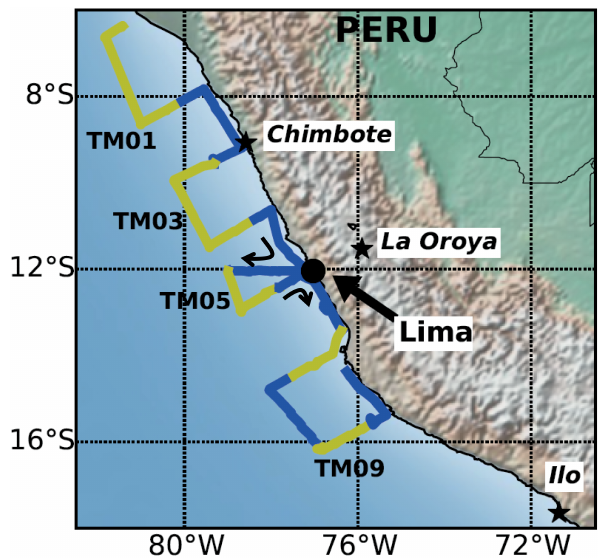
Figure 1. Track of cruise M91, showing locations of aerosol sam- ples TM01–TM10 as alternating colours along the track. Also shown are the locations of the megacity of Lima and the smelters at Chimbote, La Oroya, and Ilo.